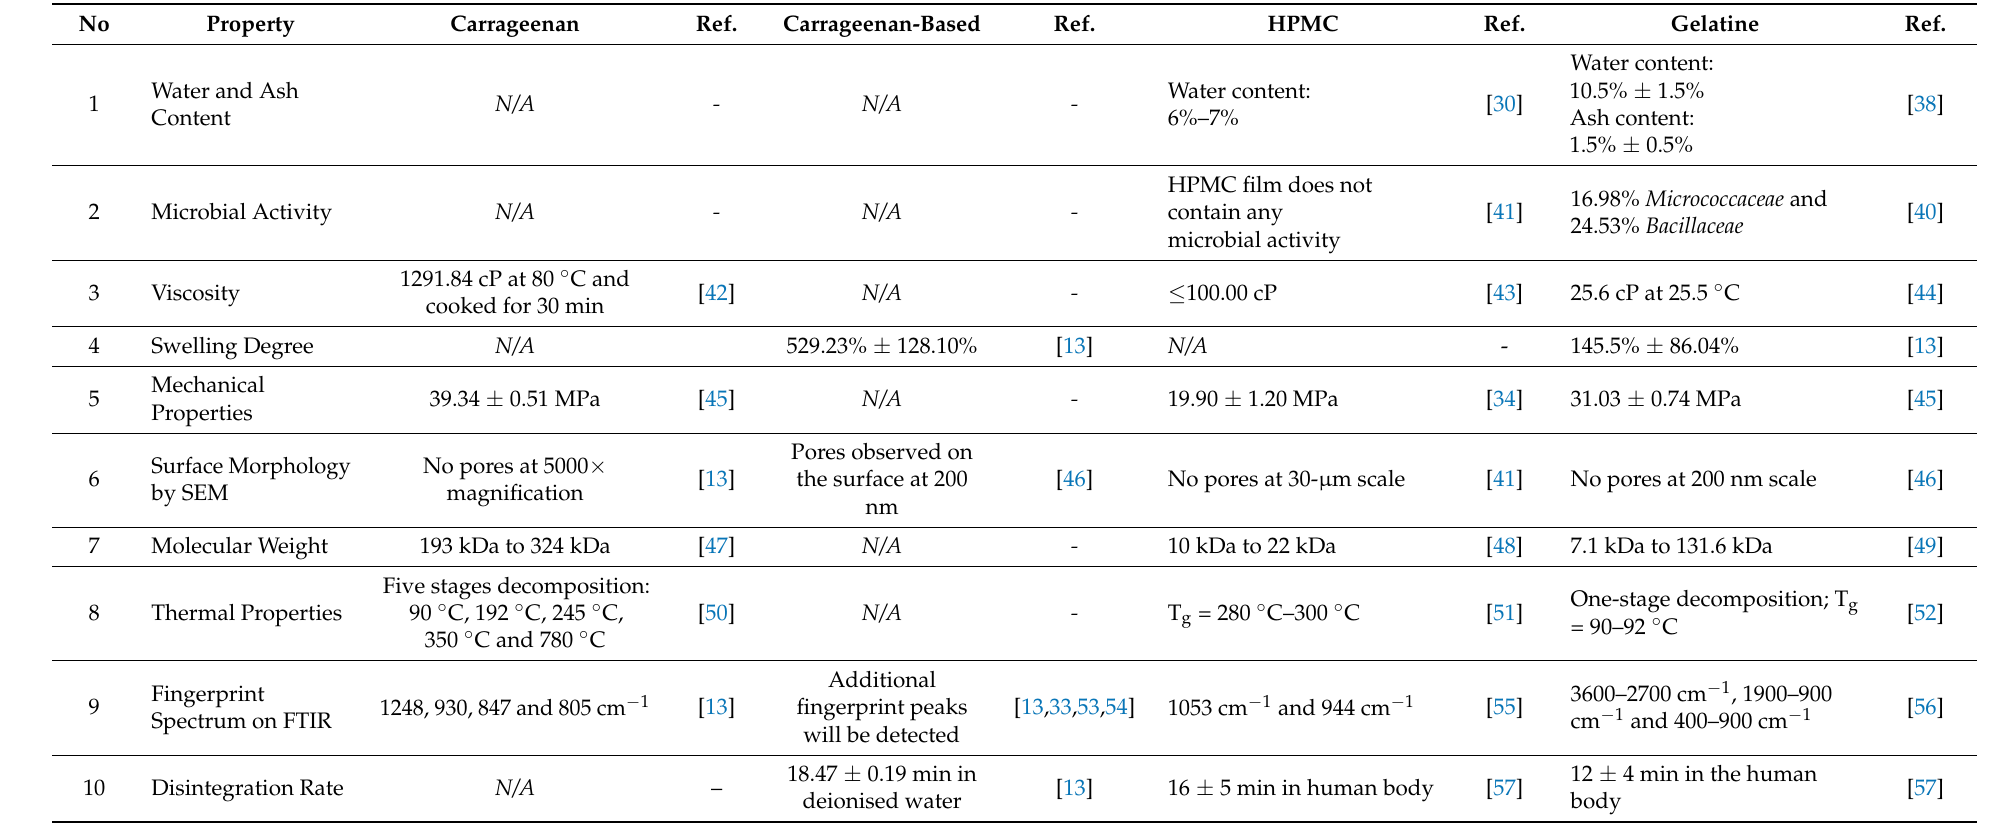
Table 7. Comparison of hard-capsule